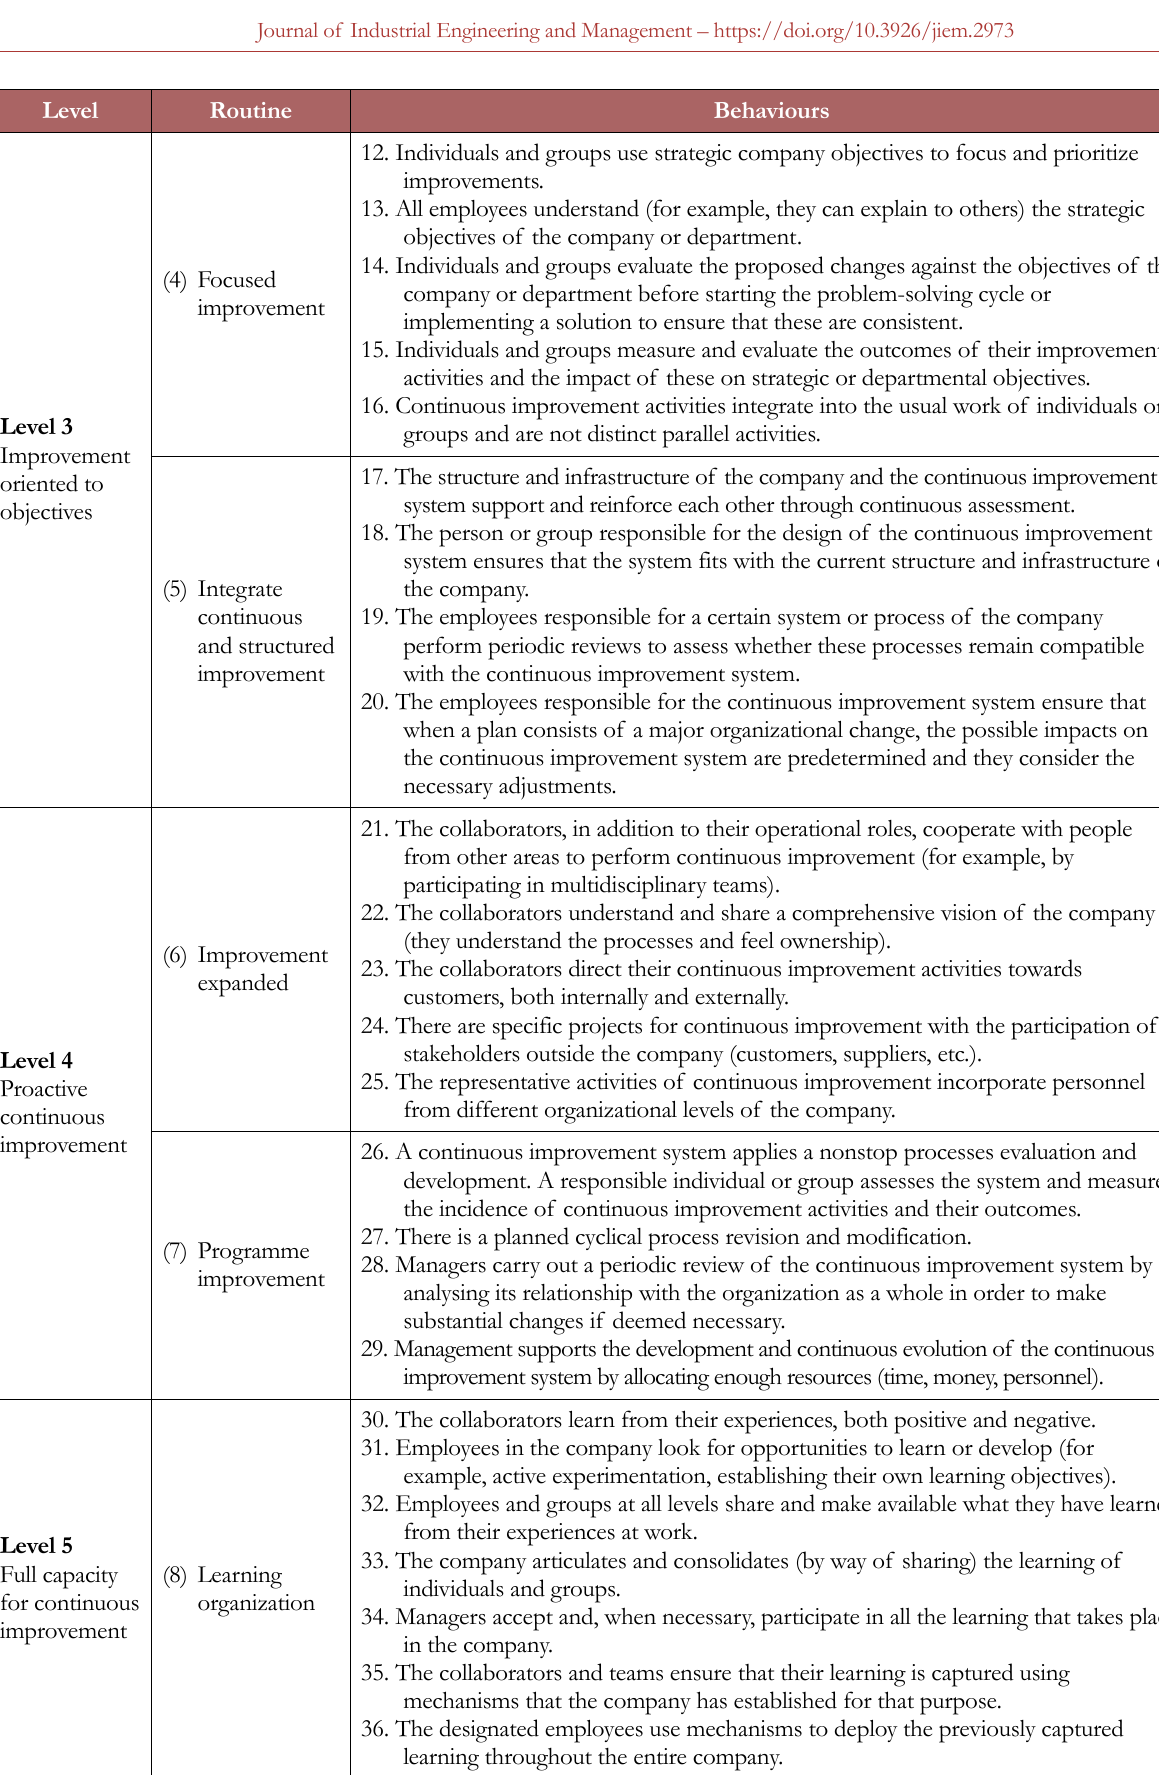
Table 1. Extension of the Bessant et al. (2001) model by Marín-García and García-Sabater (2010,